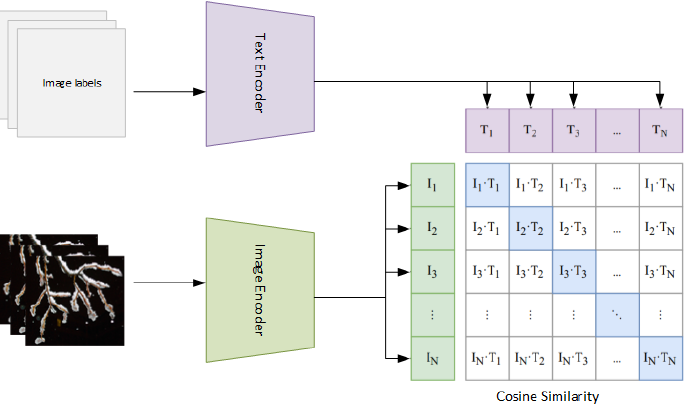
Figure 2. CLIP [8] model as a contrastive pre-training approach.